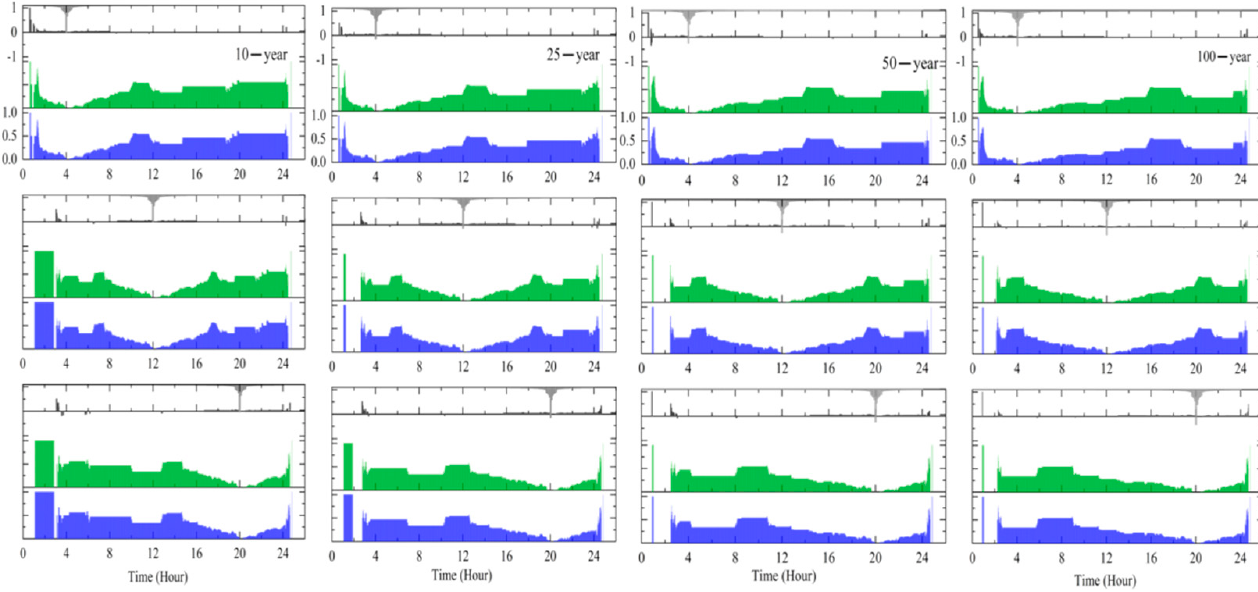
Figure 8. The fraction of road inundation reduction in different rainfall patterns of long-term events. The dark grey area is the scheme of pipe enlargement (PE), the green area is the GI scheme, and the blue area is GI + PE. Table 3. Average reduction rate of road inundation in short-term events.